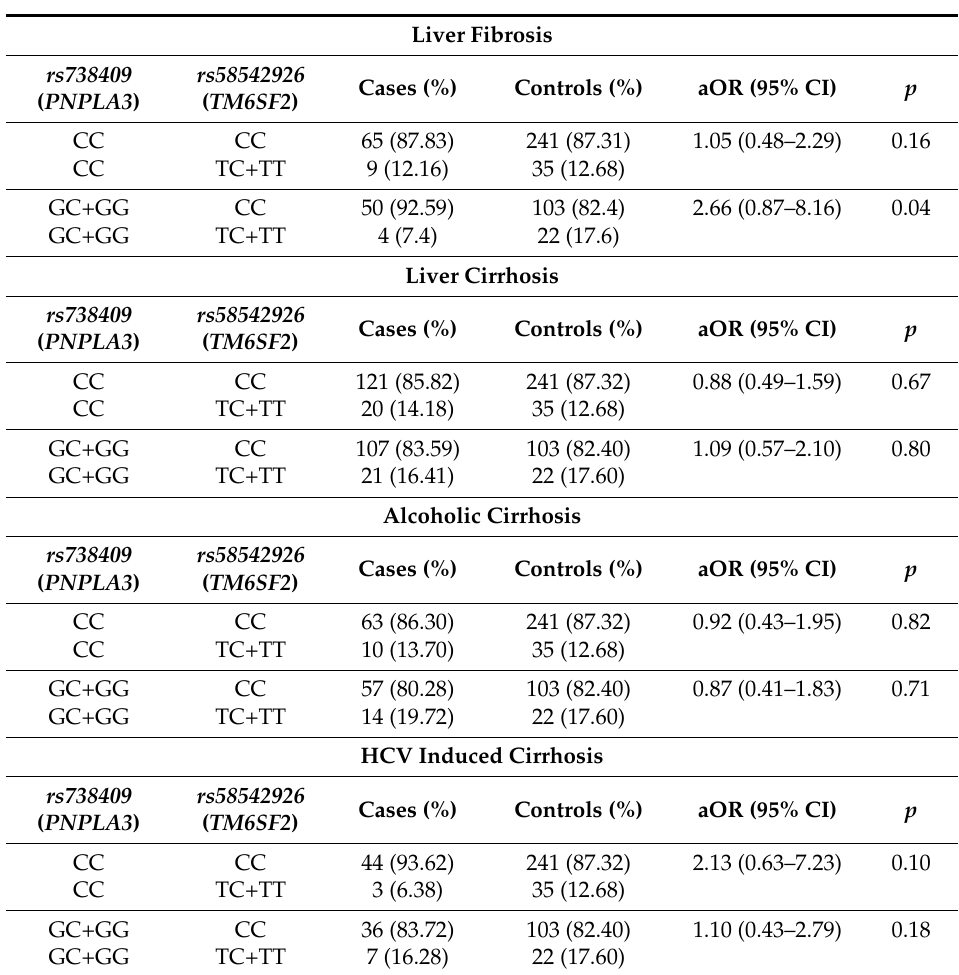
Table 4. Combined analysis of PNPLA3 and TM6SF2 genotypes.